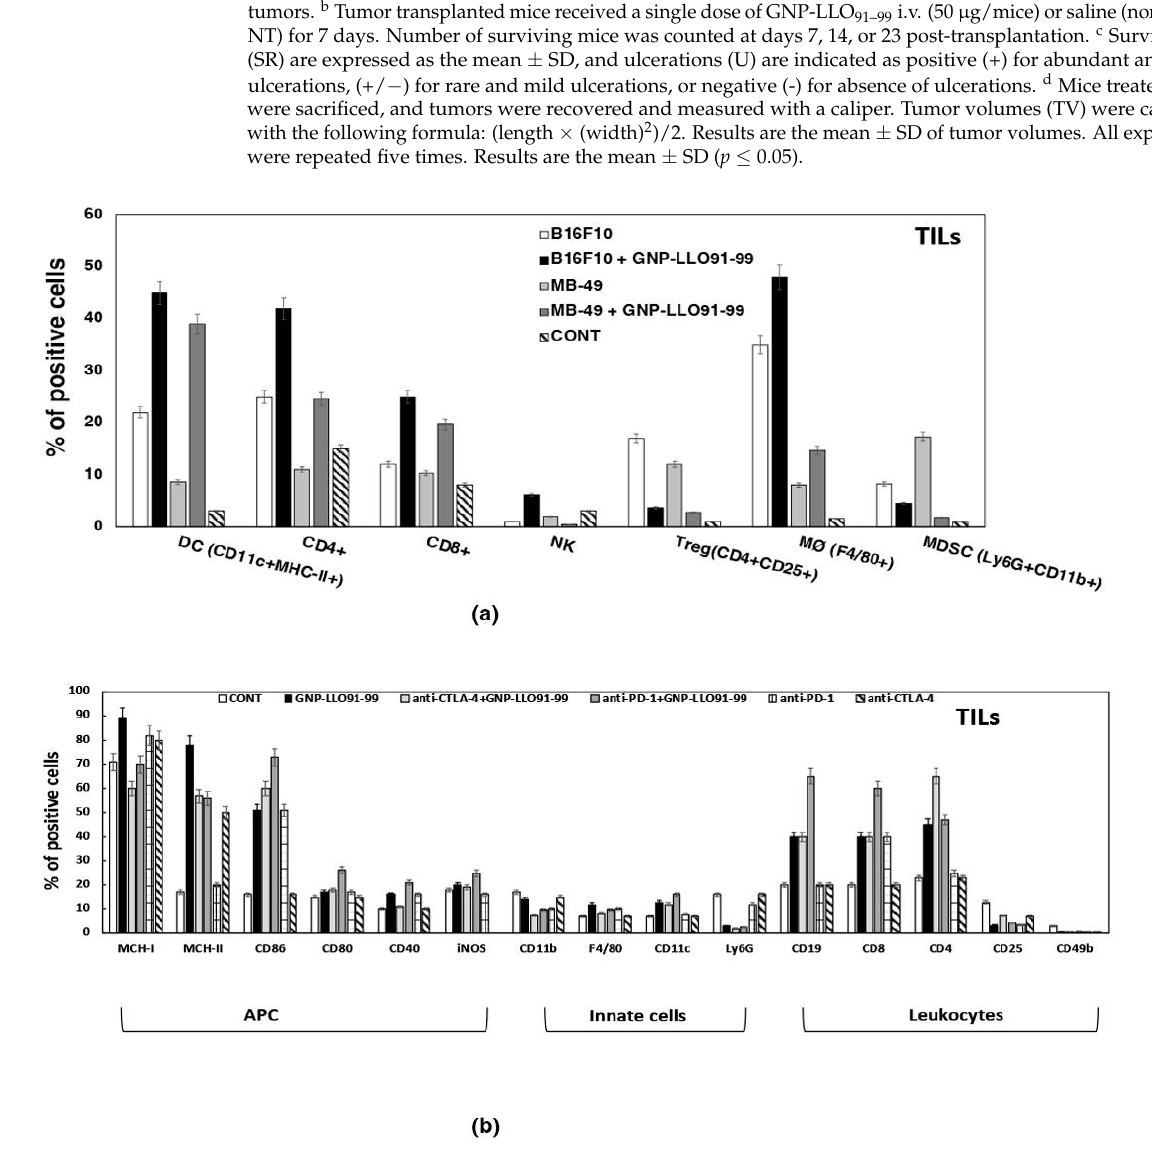
Figure 5. GNP-LLO 91–99 nanovaccines are effective immunotherapies in mice models of BC. ( a ) Mice s.c. transplanted with B16.F10 melanoma or MB-49 BC cell lines and treated or not with GNP-LLO